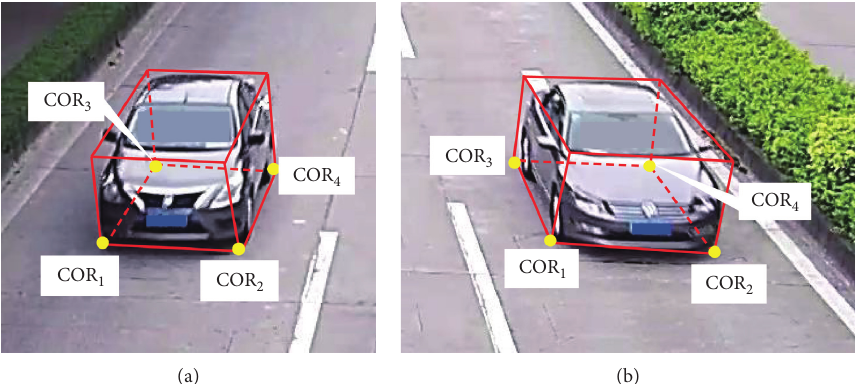
Figure 17: 3D bounding boxes on vehicles in different lanes. (a) Vehicle in lane 3; (b) vehicle in lane 1. The definitions of some bounding box’s corners in world coordinates are as follows: COR 1 is the right-front-lower corner, COR 2 is the left-front-lower corner, COR 3 is the right-rear-lower corner, and COR 4 is the left-rear-lower corner. As can be seen, for a vehicle’s bounding box in lane 3, edge COR 2 COR 4 is visible while edge COR 1 COR 3 is not. The situation is reverse when the vehicle is in lane 1. Therefore, the edges of bounding boxes for calculating the length, height, or space headway should be chosen differently for vehicles in different lanes.